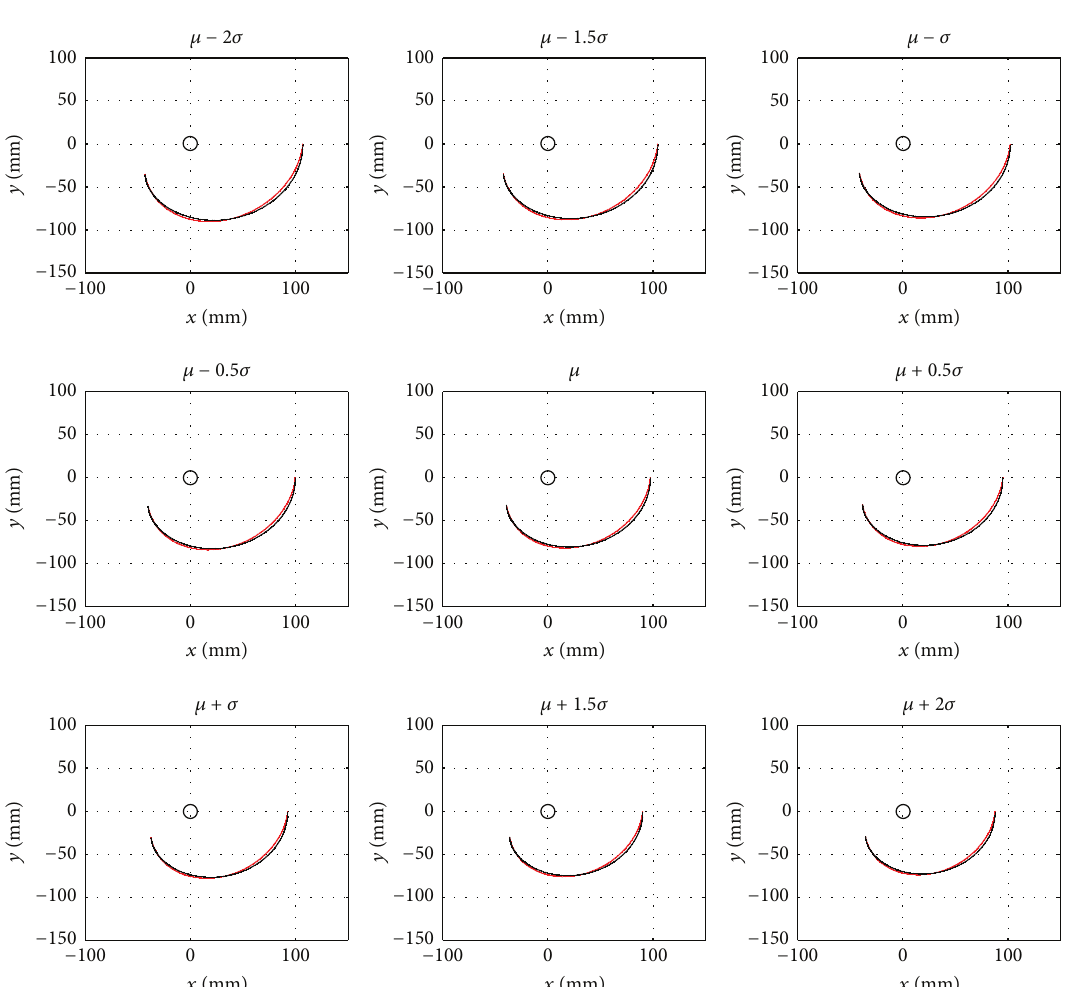
Figure 10: Error tracking of the mechanism (a) according to the natural path of flexion and extension of the middle finger and (b) percentage error in the path.